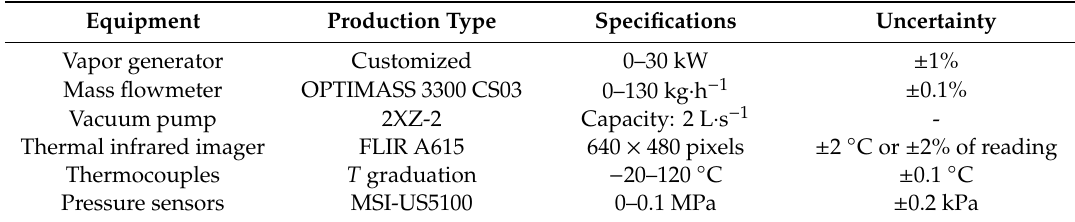
Table 1. Equipment used in the present experiment.